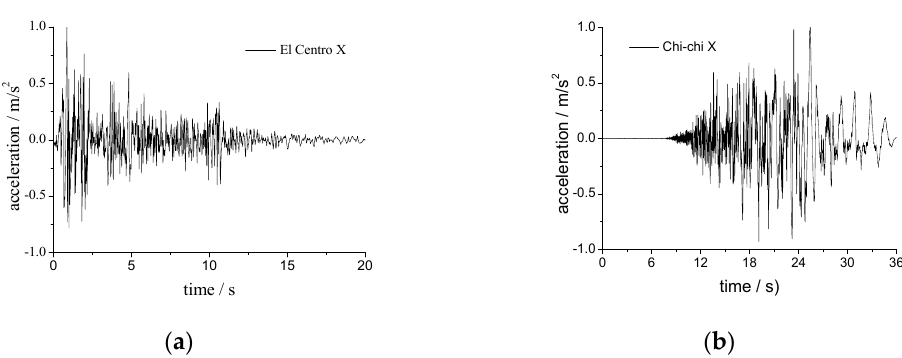
Figure 8. Longitudinal test seismic wave: ( a ) El Centro wave, ( b ) Chi-chi wave.